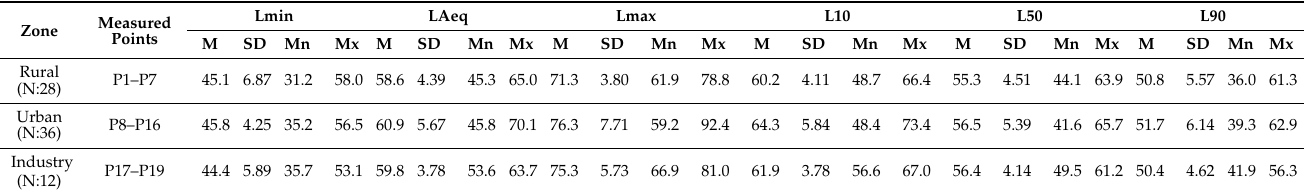
Table 1. Descriptive statistics of sound measurements.